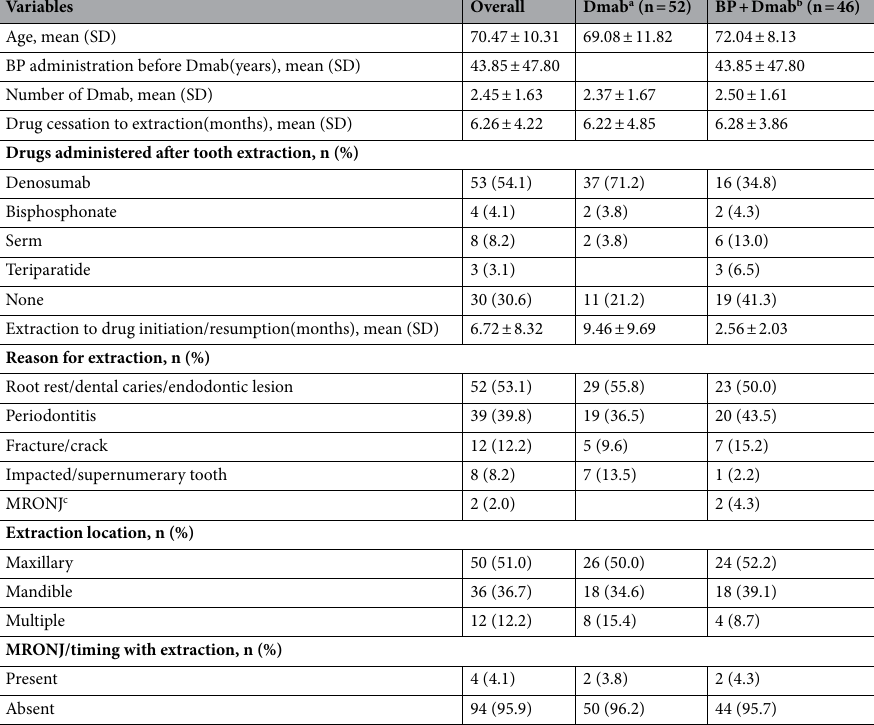
Table 2. Characteristics of patients treated with denosumab and bisphosphonate with extraction. Values are mean (SD), n (%) as indicated. BP bisphosphonate, Dmab Denosumab, SD Standard Deviation. a Receiving only denosumab. b Receiving bisphosphonate as first treatment and denosumab as second treatment. c MRONJ was induced by existing periodontal inflammation, and as a result, tooth extraction was performed. The reason for extraction has duplicate